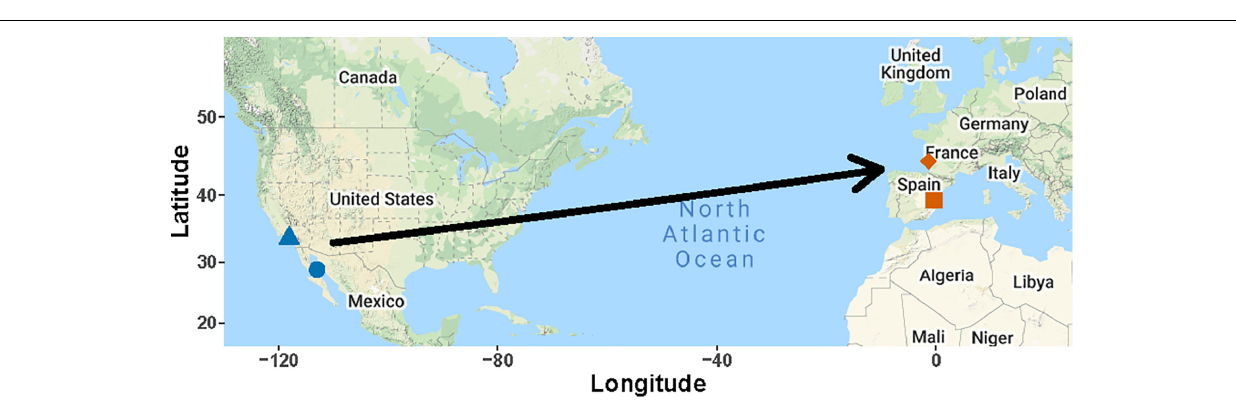
FIGURE 9 | Colonization of Europe by elegant terns. The primary colony, Isla Rasa in the Gulf of California is shown by the blue circle, and the location of three colonies on the Pacific Coast of California is shown by the blue triangle. European breeding has occurred at L’Albufera de Valencia, Spain (red square) and Banc D’Arguin, Gironde, France (red diamond) (Dies et al., 2019; Stoddart and Batty,